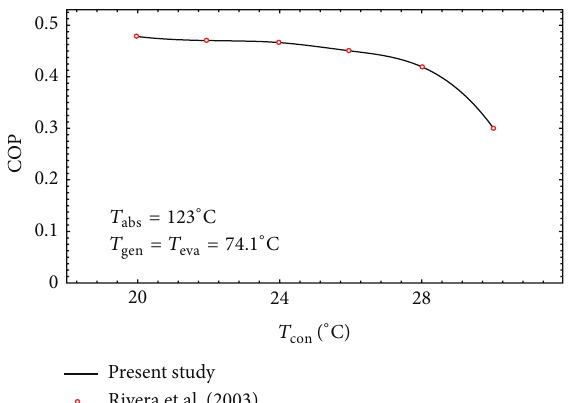
Figure 3: Validation of the simulation model developed for AHT system.